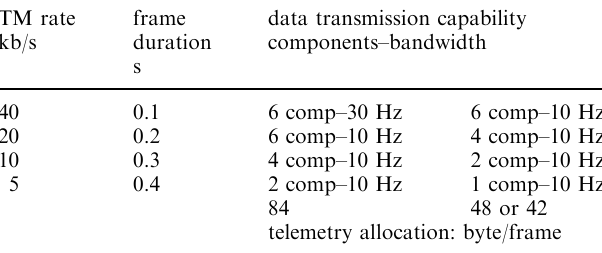
Table 1. IESP data transmission capability with